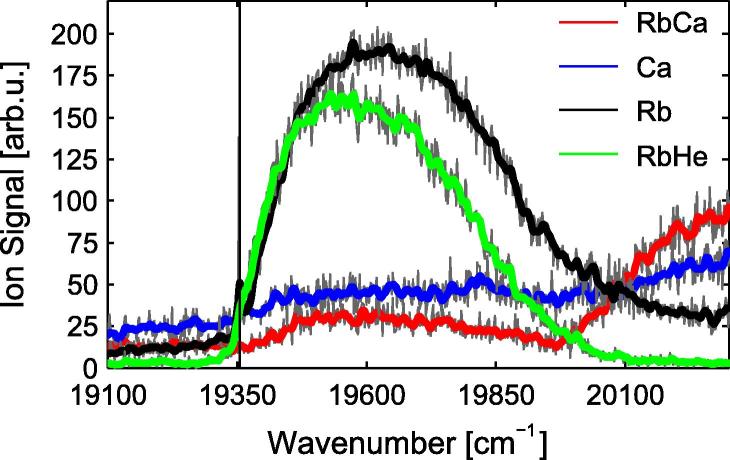
Close-up of the transition around 19 600 cm−1 in the RbCa ion yield. The ion yields for 40Ca (blue), 85Rb+87Rb (black), 85RbHe+87RbHe (green) and 85Rb40Ca+87Rb40Ca (red) are shown, the vertical line indicates the free atom Rb (4d 2D) ← Rb (5s 2S) transition. It can be seen that the RbCa signal follows the Rb and Rb-He signal. The peak in the RbCa ion yield is not correlated to a RbCa transition, as explained in the text. (For interpretation of the references to color in this figure legend, the reader is referred to the web version of this article.)